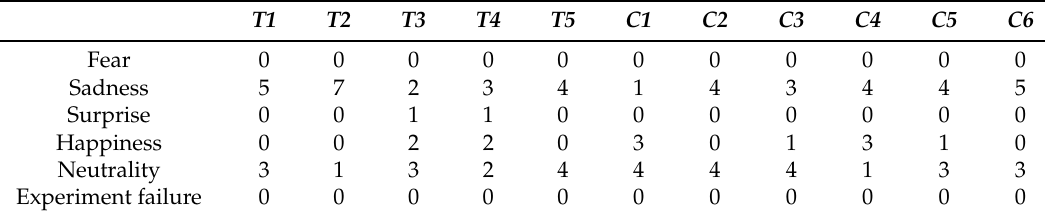
Table 4. Emotional effects of the benchmark tests. In the columns are indicated the number of people that reacted to the considered situation with the emotion on the left. Data obtained by the network in [21], trained with the Ensemble 1 database using the data augmentation and the z-score normalization. T1 T2